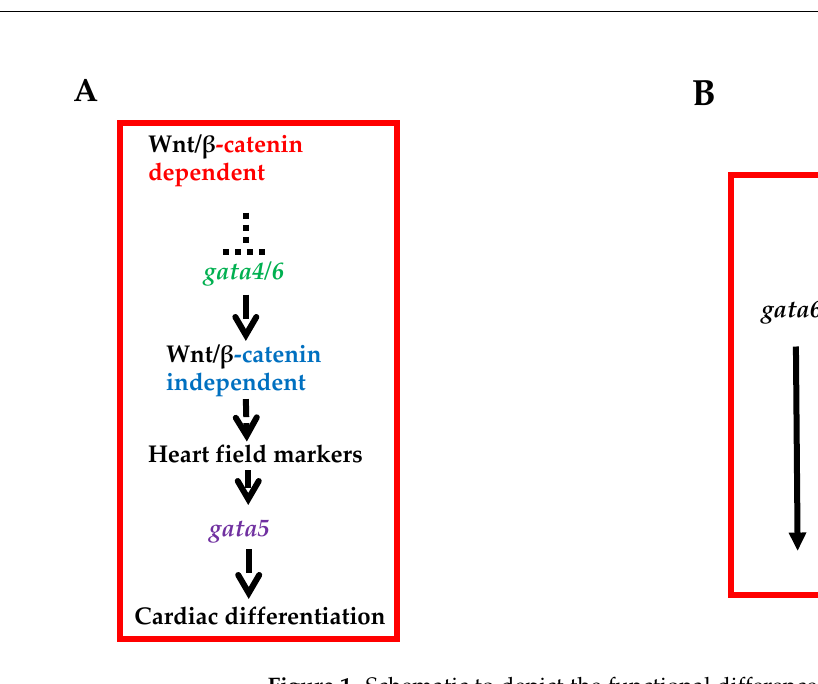
Figure 1. Schematic to depict the functional differences between cardiogenic factors during heart formation. ( A ) β -catenin-dependent Wnt signalling represses gata4/6 , which in turn activates non- canonical Wnt signalling for induction of heart field markers after which gata5 is induced to promote cardiac differentiation. ( B ) All cardiogenic GATA factors function after induction of early cardiogenic transcription factors where sox7 and sox18 act downstream to mediate only some of gata4 ’s function, not those of gata5 or gata6 during cardiomyogenesis. Abbreviations: TFs, Transcription factors. X1 and x2 indicate yet unidentified intermediary factors. (Panel B as in